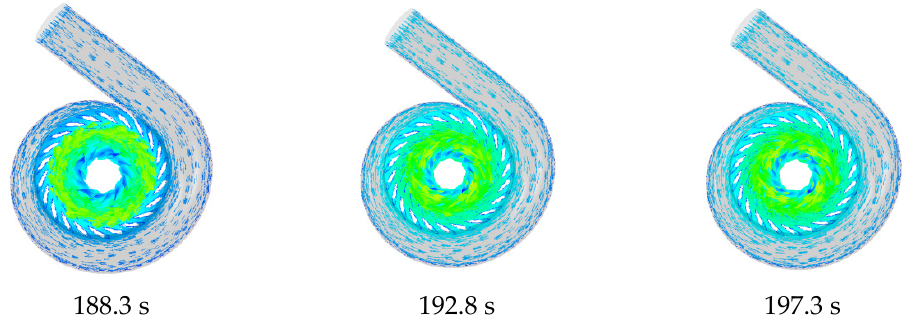
Figure 8. The internal flow characteristic of the PT unit during turbine start-up. Figure 9 shows the flow changes in the runner during start-up. When the machine has just been turned on, the opening of the guide vanes is quite small, and the vortexes are generated in the blade channels at the runner inlet side. As the opening of the guide vanes increases, the vortexes at the runner inlet side decrease, and at t = 18.7 s, the vortexes are located in the middle of the runner blade channels. At t = 26.7 s, the opening of the guide vane is slightly closed, and the vortex structure in the runner blade channels becomes complicated. The opening of the guide vanes basically remains constant until 107.5 s, and the flow in the runner does not change much during this period either. After t = 134.4 s, the opening of the guide vanes increases largely, the vortex area in the runner flow passage decreases, and the streamline becomes smoother gradually.